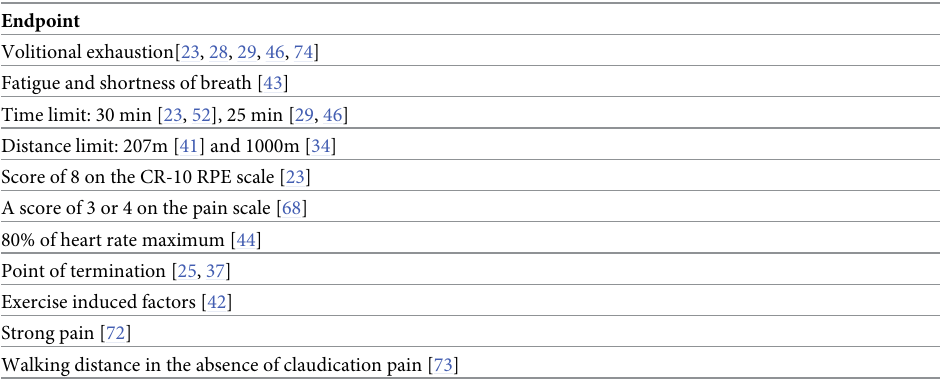
Table 3. Additional test endpoints adopted in treadmill